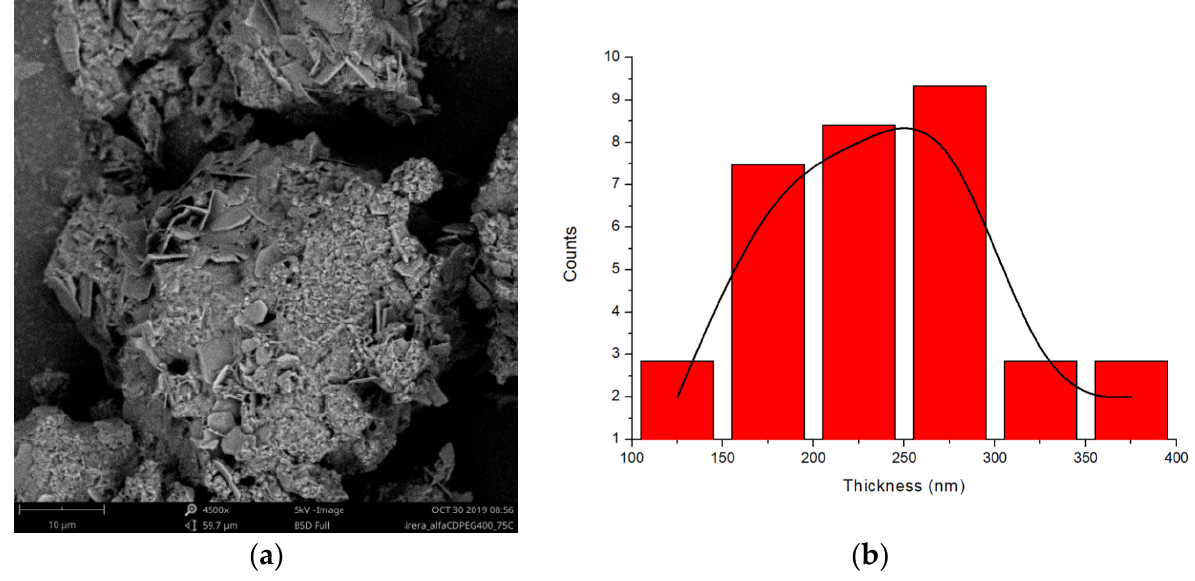
Figure 8. ( a ) SEM micrograph of the reaction of PEG400 and α -CD (1:2 molar ratio) at 75 °C (BSE electrons, 4500×, 5 kV); ( b ) Thickness distribution of the lamellae.